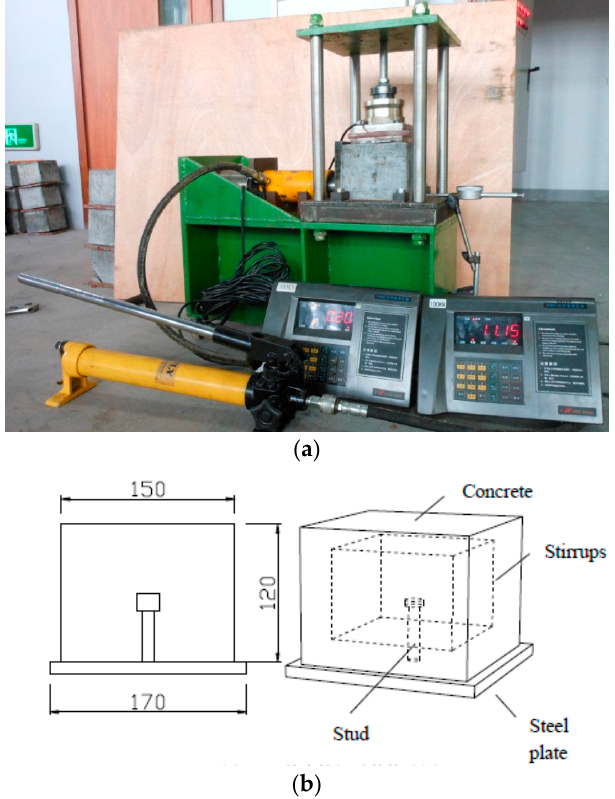
Figure 1. Test setup of the single stud shear connector: ( a ) Test device; ( b ) Test specimen.